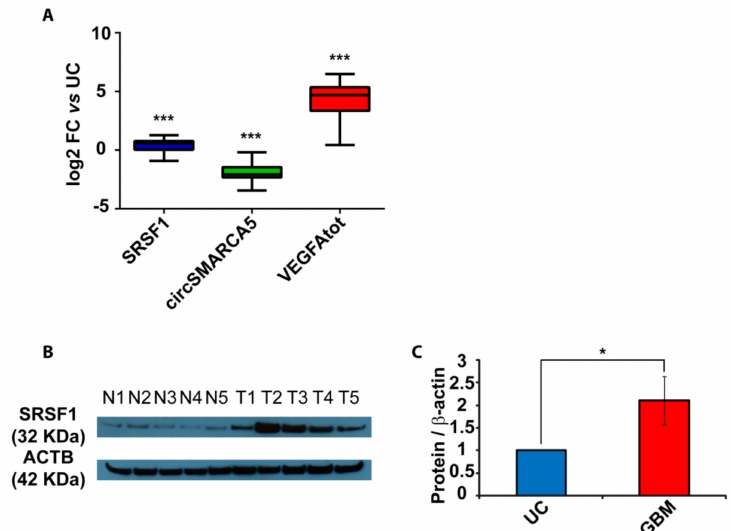
Figure 2. SRSF1, circSMARCA5 and VEGFA expression in GBM biopsies and unaffected controls (UC). ( A ) Box-and-whisker plots, representing the expression of SRSF1, circSMARCA5 and total VEGFA RNA in the studied cohort. Data are represented as log 2 fold change (FC) values versus UC. (*** p -value < 0.001, N (GBM) = 31, N (UC) = 20, Mann–Whitney test). ( B ) Western blot of SRSF1 in a selection of UC (N) and GBM (T) samples. ACTB was used as a loading control. ( C ) Bar graph representing densitometric quantification of SRSF1. Data, shown as mean ± standard deviation, represent fold change versus UC (* p -value < 0.05, N (GBM) = 14, N (UC) = 8, two-sample t